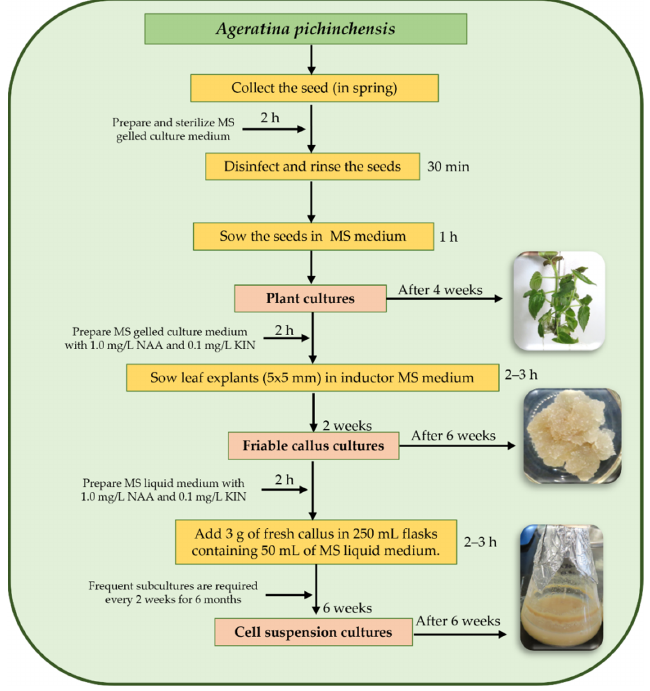
Figure 6. Representation of a general scheme for establishing a callus and cell suspension culture for A. pichinchensis . NAA: α‐ naphthaleneacetic acid; KIN: 6 ‐ furfurylaminopurine.